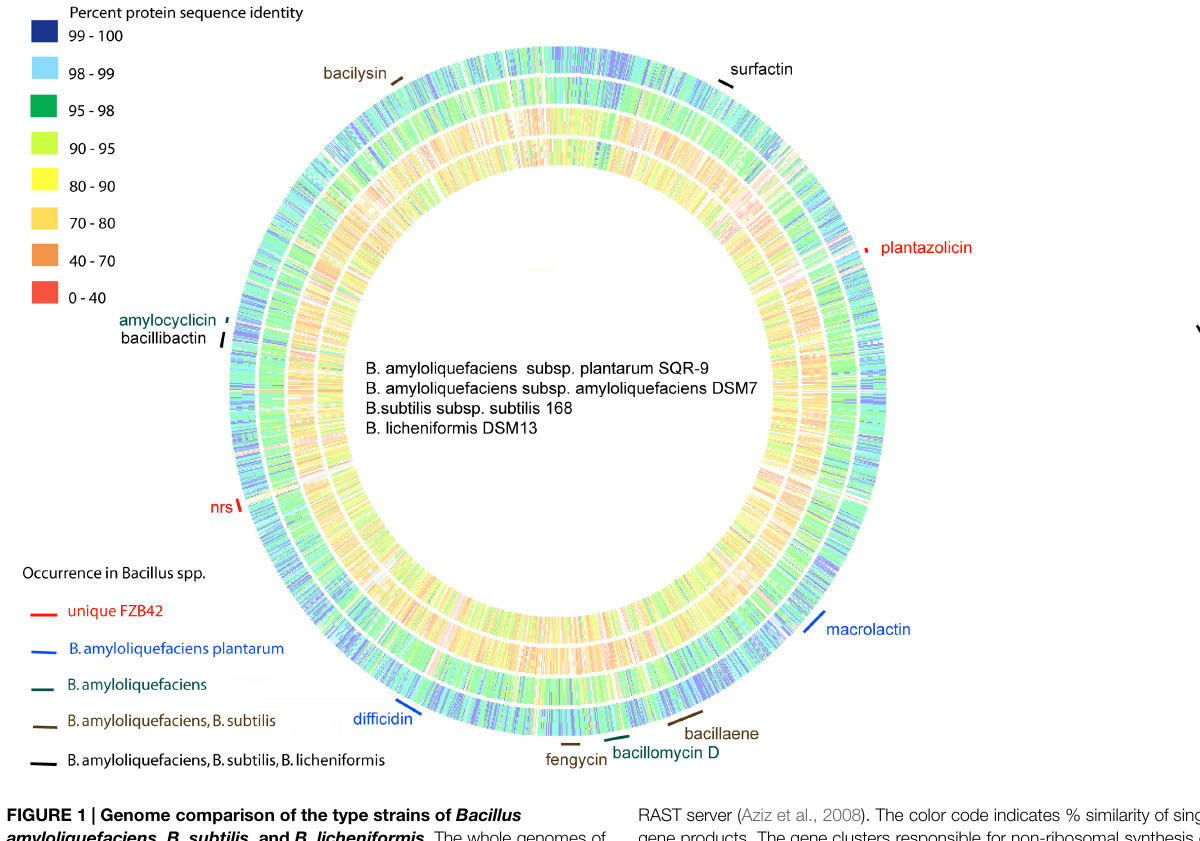
FIGURE 1 | Genome comparison of the type strains of Bacillus amyloliquefaciens , B. subtilis , and B. licheniformis . The whole genomes of B. amyloliquefaciens plantarum SQR-9 (outside circle), B. amyloliquefaciens amyloliquefaciens DSM7 T (second circle), B. subtilis subtilis 168 T (third circle), and B. licheniformis DSM13 T (inner circle) were aligned with FZB42 T using the